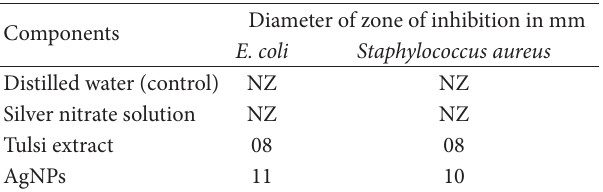
T 1: Values of zones of inhibition obtained by disc diffusion